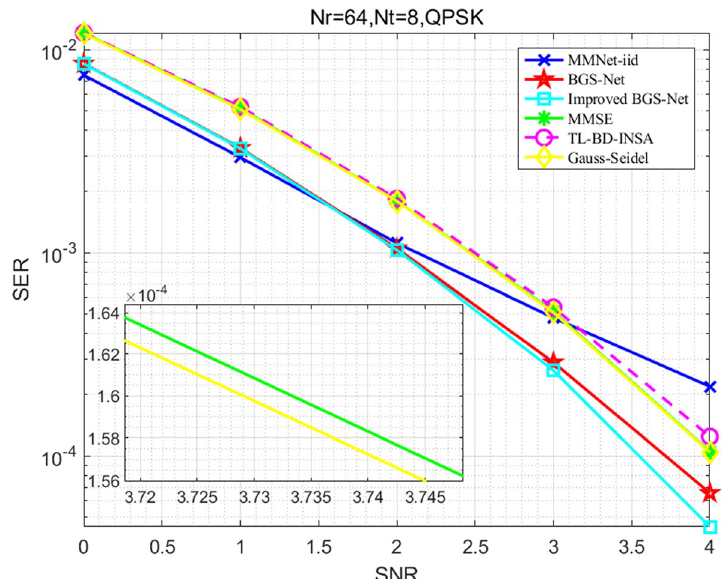
Fig. 21 SER performance comparison of different algorithms for N t = 8,N r = 64 , QPSK, MAUE system with ξ r = 0, ξ t = 0.2